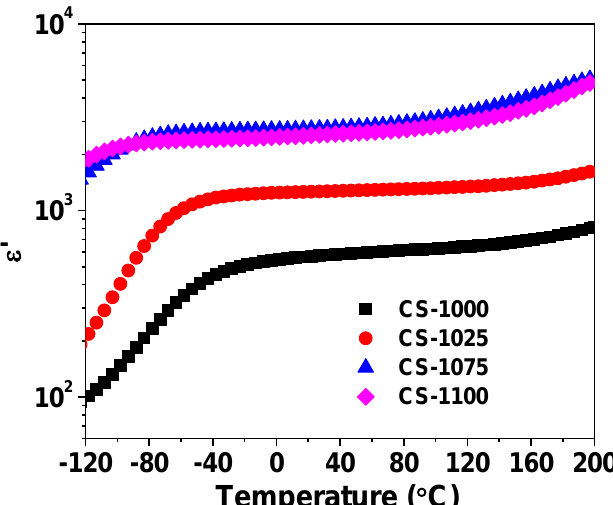
Figure 3. Temperature dependency of relative permittivity ( ′) at 10 kHz for the NSCTO ceramics.